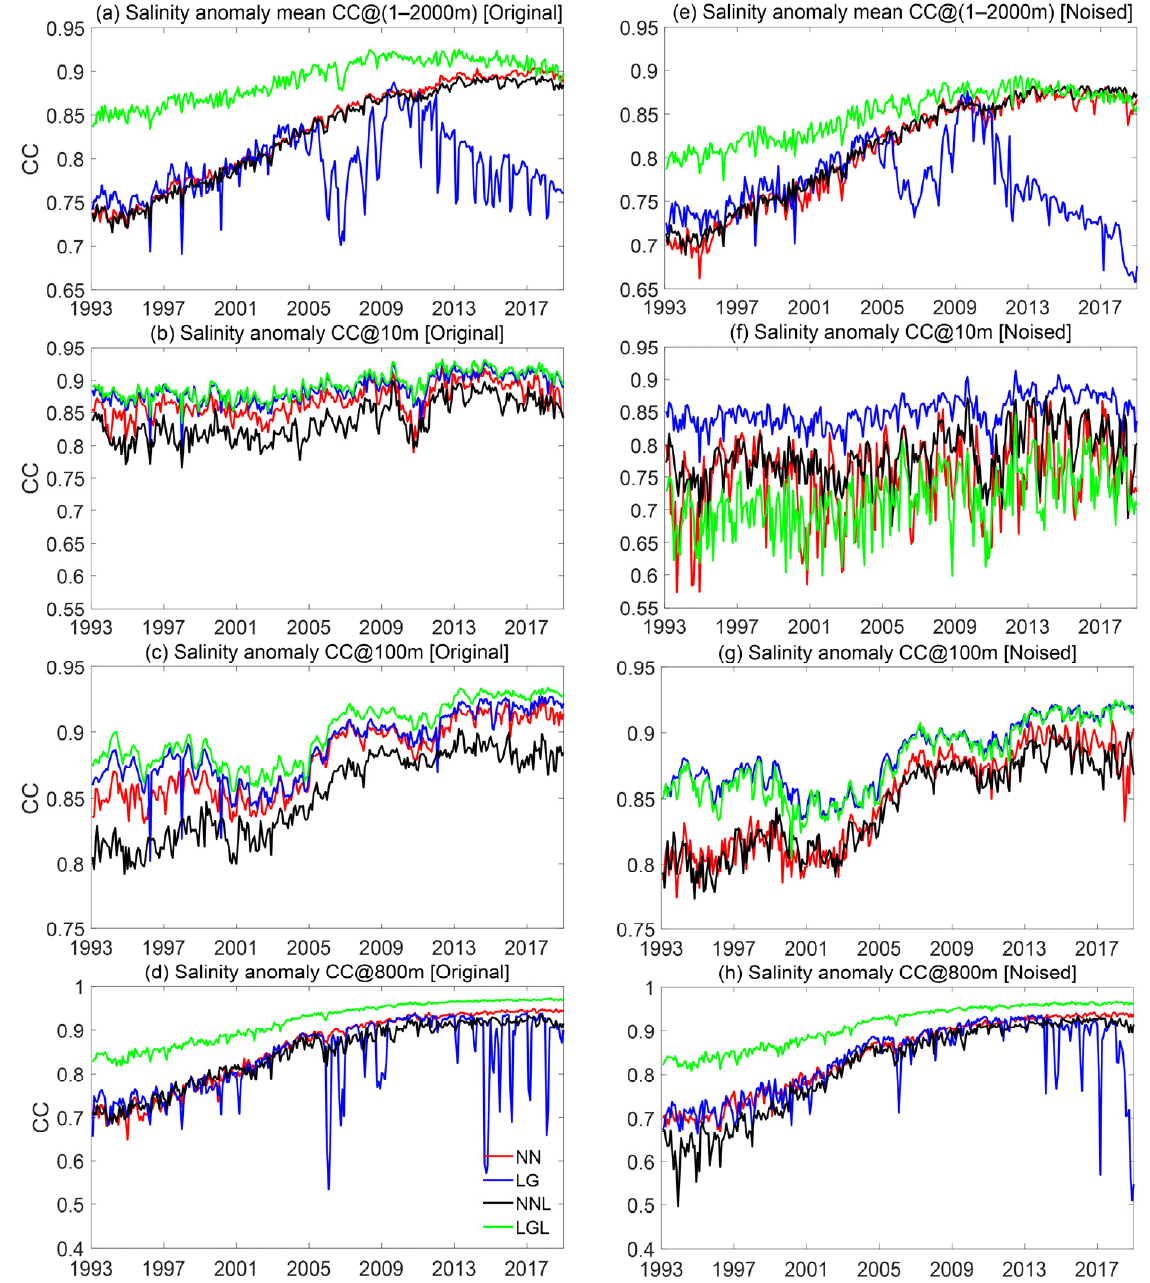
Figure 14. Time series of global average CCs in the 1–2000 m depth range and at the three layers of the four experiments. ( a – d ) Experiments performed with the original synthetic dataset. ( e – h ) Experiments performed with the noised synthetic dataset.